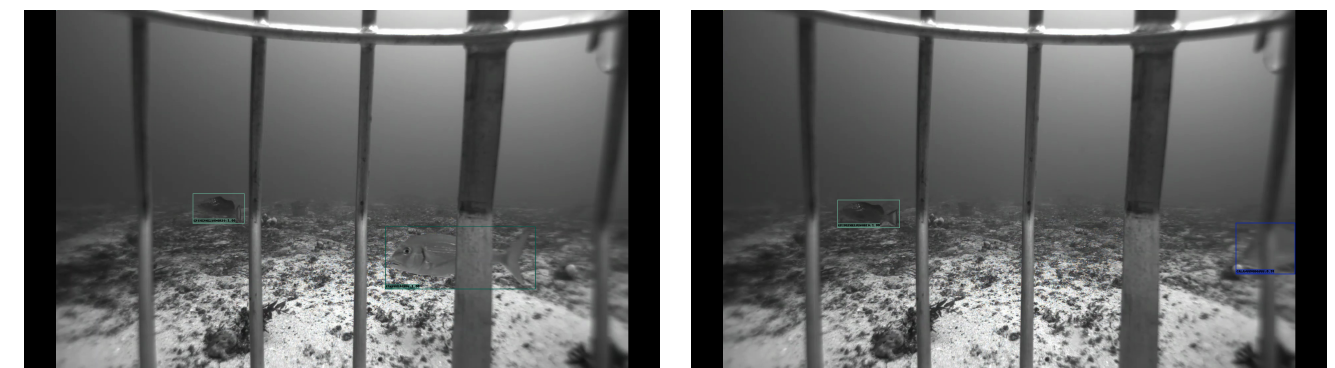
Figure 6. MobileNetv3 backbone qualitative outputs. These sample outputs show the missed detection using the MobileNetv3 backbone, whereas the VGG backbone detects them. One and two fish, respectively, are not detected in the first and second images of the first row. There is the same number of fish missed detection in the second row. However, two and three fish are not detected from the last row of